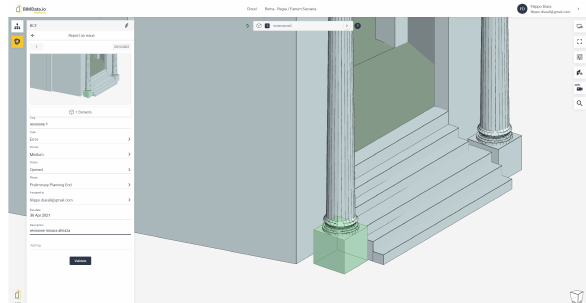
Figure 12 . BCF option: example of a request of a revision regarding height measurements related to the column base.